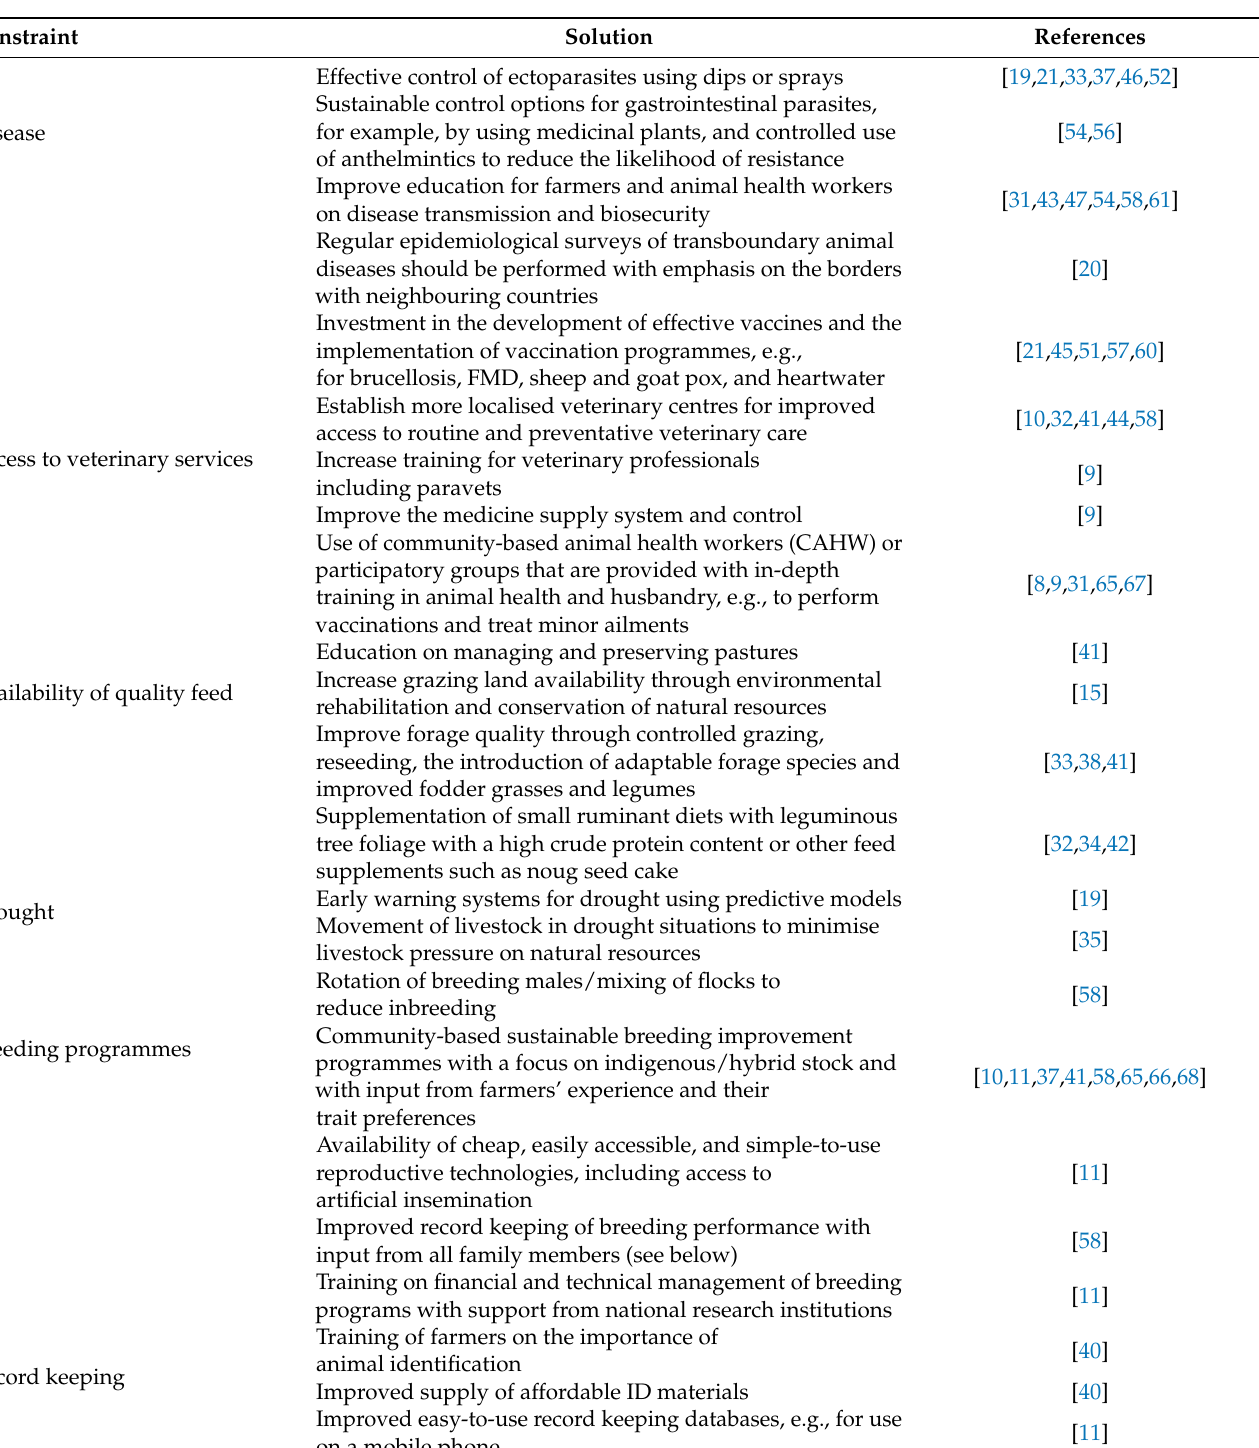
Table 3. Potential recommendations to improve small ruminant production in Ethiopia, Uganda, and Tanzania.